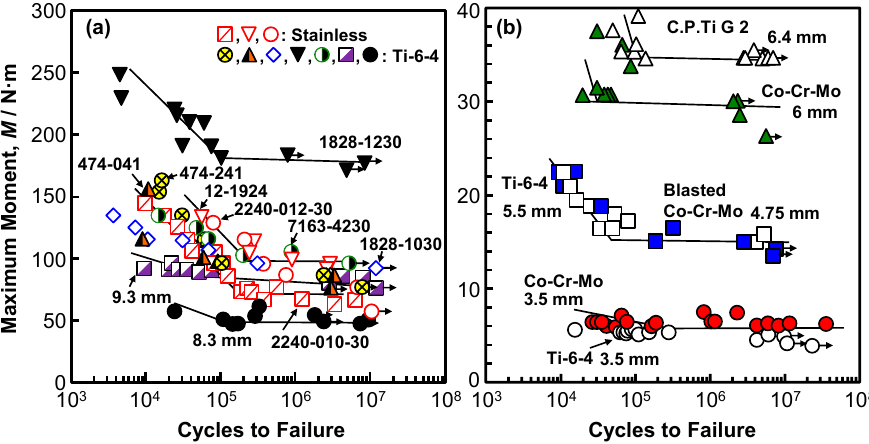
Figure 6. M–N curves of various ( a ) intramedullary nail rods and ( b ) spinal rods obtained by four-point bending durability tests.